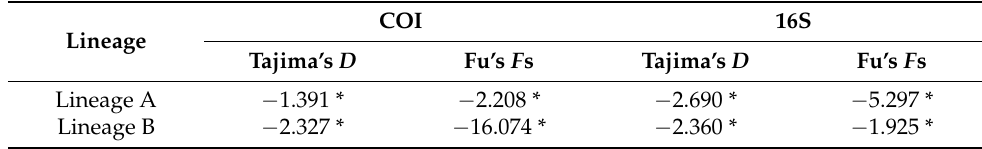
Table 4. Results of neutrality test for lineages of L. ( N. ) beka based on COI and